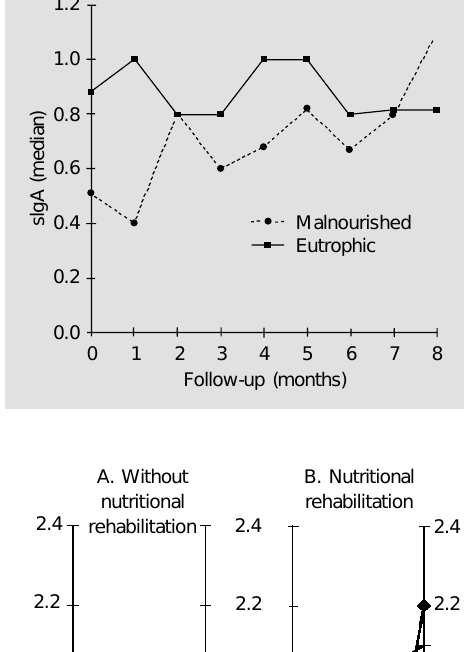
Figure 2 – Effect of nutritional rehabilitation on urinary sIgA of malnourished children who re- ceived (N = 27), or not (N = 38), nutritional rehabilitation for 8 months. Data are reported as sIgA mg/l urine. A , Without nu- tritional rehabilitation: median before 0.88 mg/l, median after 0.82 mg/l. B , With nutritional re- habilitation: median before 0.51 mg/l, median after 1.09 mg/l (P<0.05 compared to before re- habilitation, Wilcoxon test).